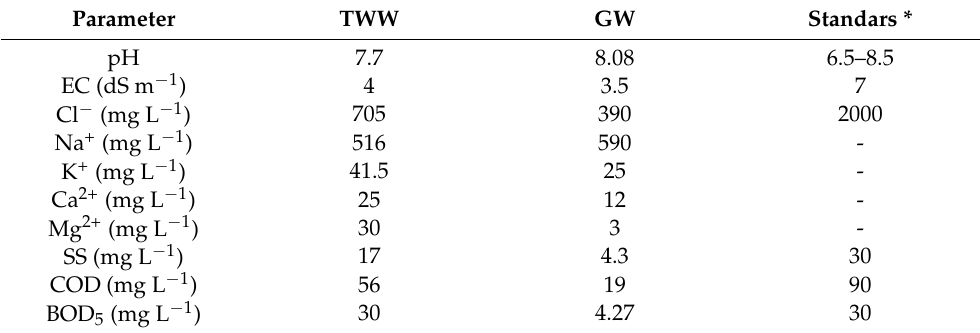
* Tunisian standards for wastewater reuse (NT 106.03).